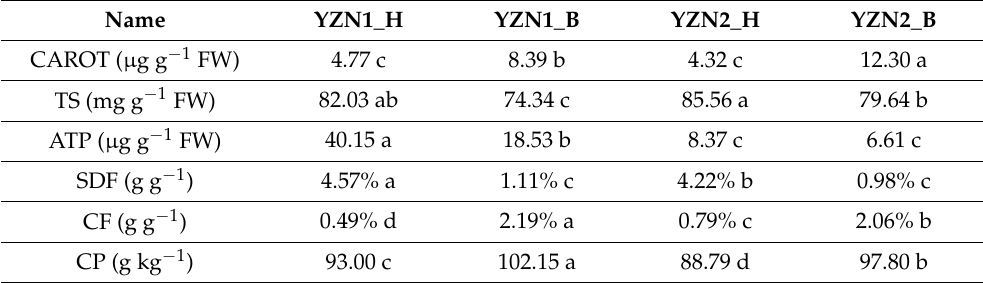
Table 2. Difference analysis of the nutrient levels in brown rice of two purple rice varieties after processing to polished